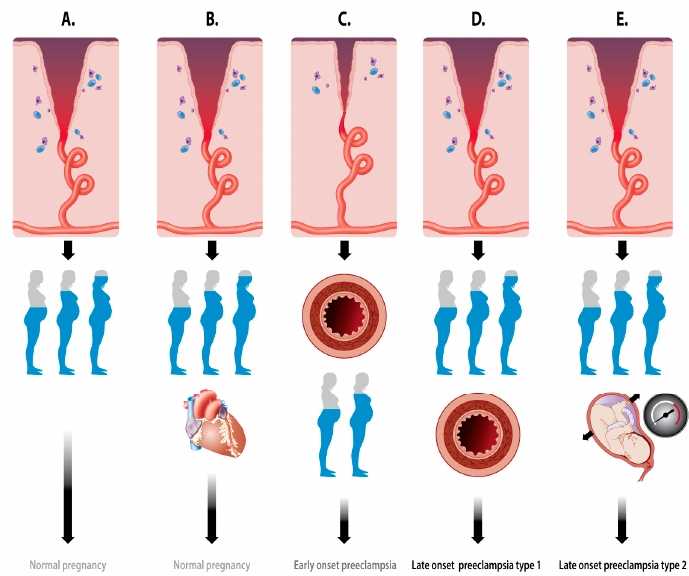
Figure 6. Schematic representation of the evolution from placentation and maternal vascular adaptation to the clinical end stage of ( A ) normal pregnancy, ( B ) normal pregnancy with cardiac signs of volume overload, ( C ) early-onset preeclampsia, ( D ) crossover late-onset preeclampsia (type I), and ( E ) high-output late-onset preeclampsia (type II). A: The normal remodeling of the spiral arteries is followed by the normal expansion of the body water volume in an uncomplicated pregnancy. B: The same situation as in panel A, but the woman presents at term with echocardiographic signs of volume overload [113]. C: Shallow spiral artery dilatation, presenting already in the first trimester with signs of endothelial activation and vascular hypertonia, followed by the suboptimal expansion of the plasma volume, and resulting in early-onset preeclampsia and poor fetal growth [39]. D: The normal remodeling of the spiral arteries is followed by the normal expansion of the body water volume with subsequent secondary endothelial activation, resulting in crossover from a high volume / low resistance to a low volume / high resistance circulation, eventually presenting as late-onset preeclampsia type I [38]. E: The normal remodeling of the spiral arteries is followed by the normal expansion of the body water volume in women with high intra-abdominal pressure, resulting in high-output late-onset preeclampsia type II